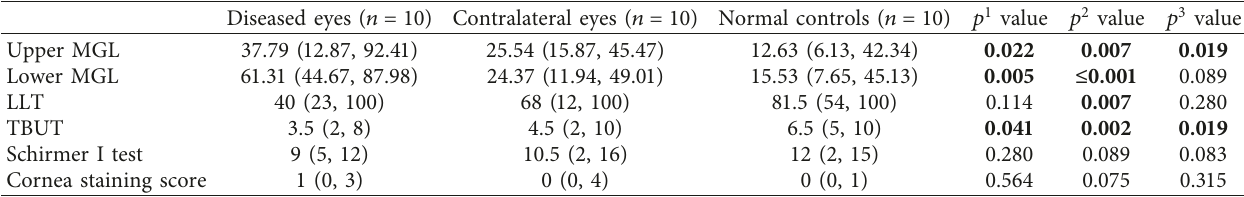
Table 2: Comparison of the meibomian gland structure and function between the RT and control group.